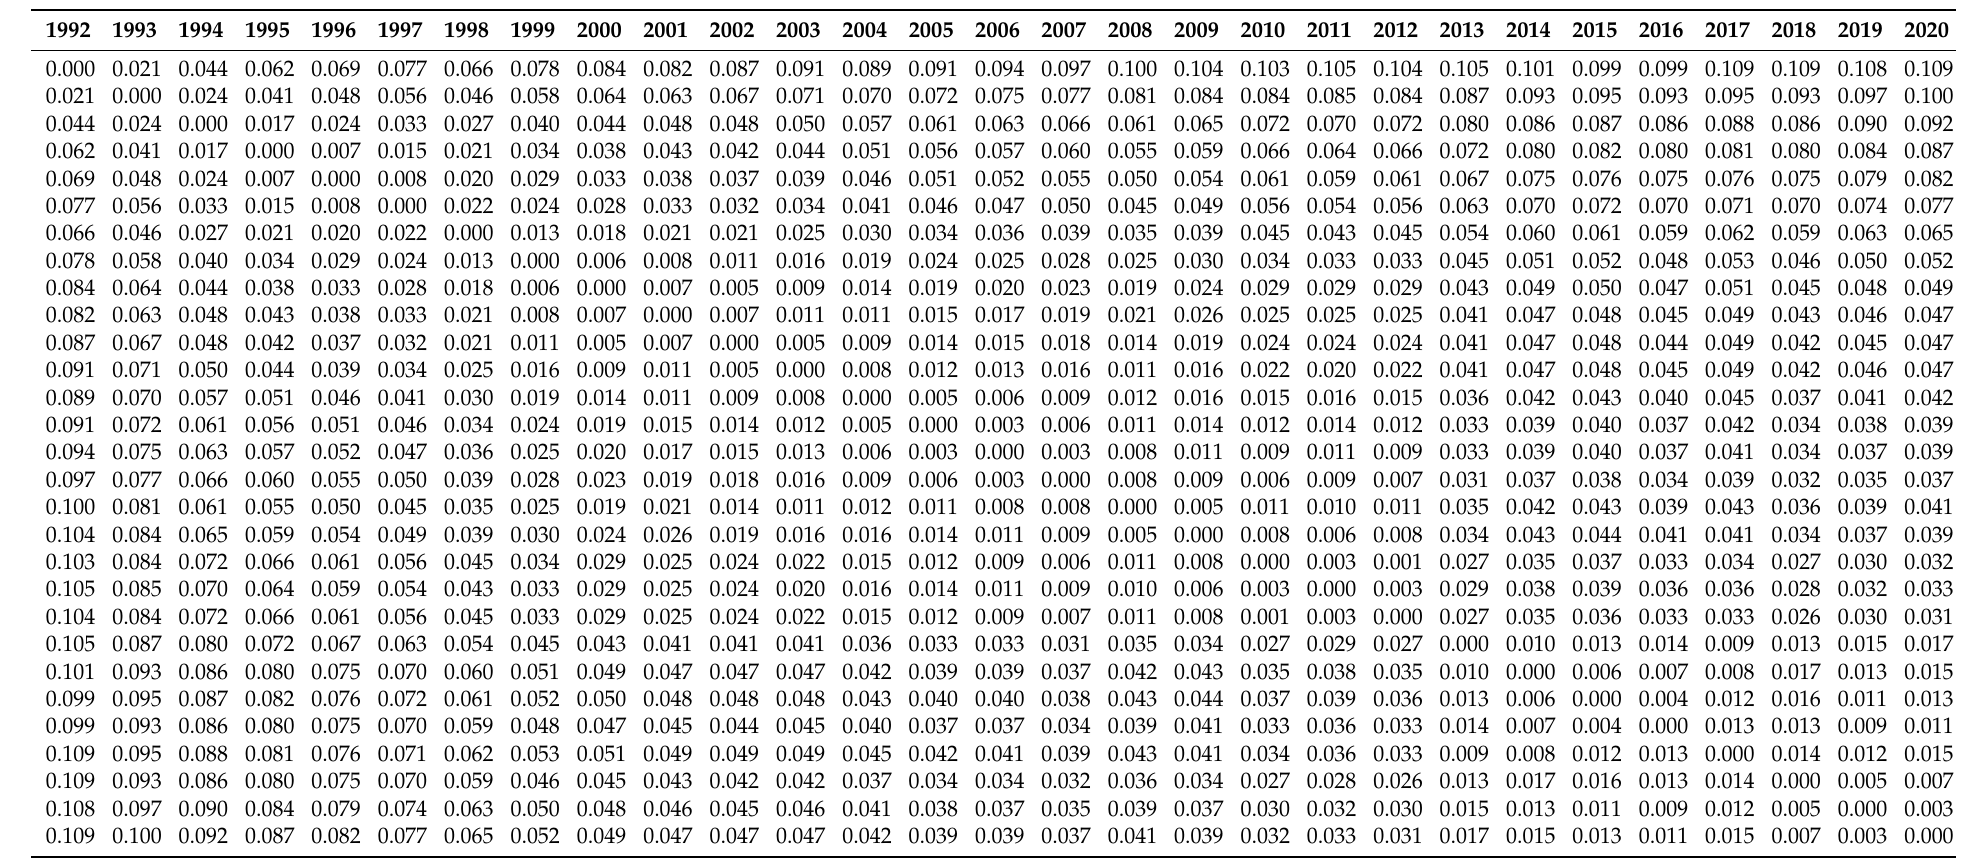
Table A1. Intensity of changes in the structure of employment (NPS) in mining enterprises in Poland in